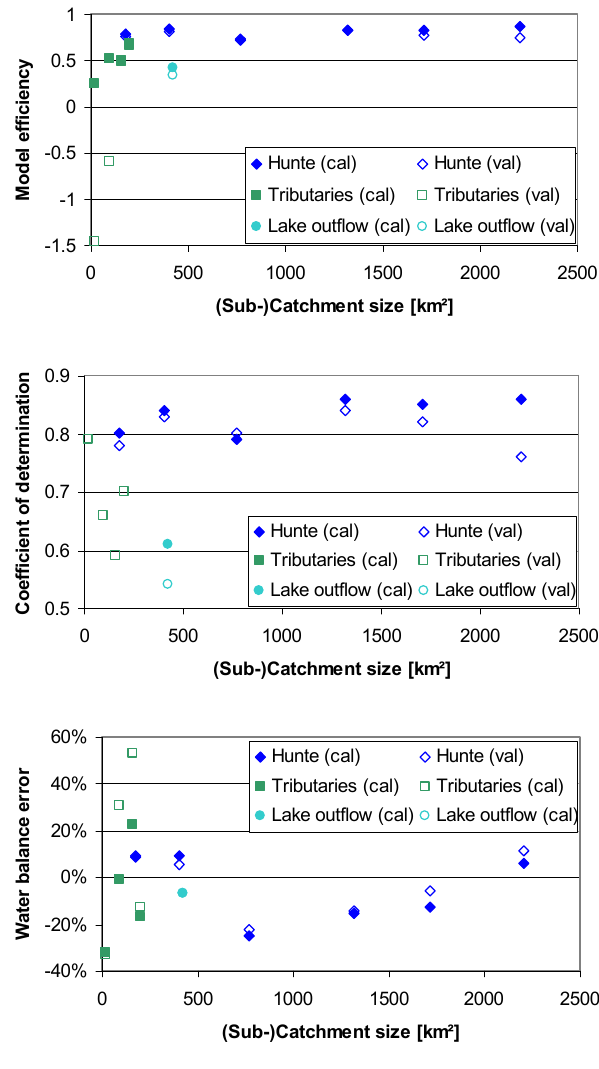
Fig. 4. Scale dependency of different quality measures (model efficiency, coefficient of determination, water balance error) for the calibration (1986–1995) and validation (1996–2005) peri-